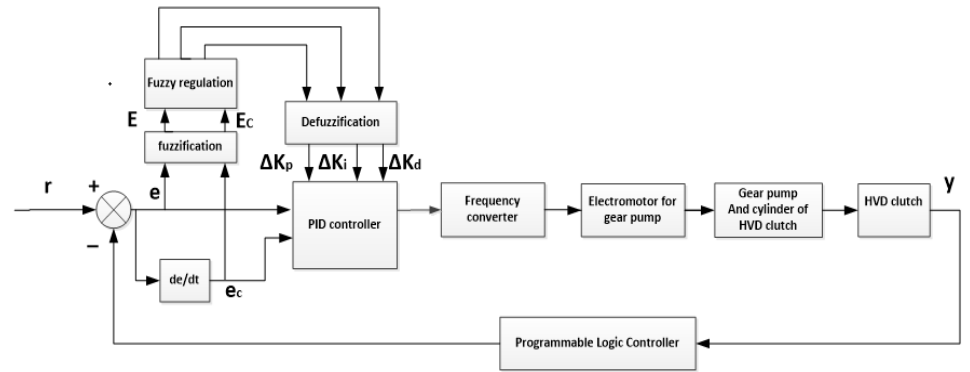
Figure 4. System block diagram based on the Fuzzy-PID controller.